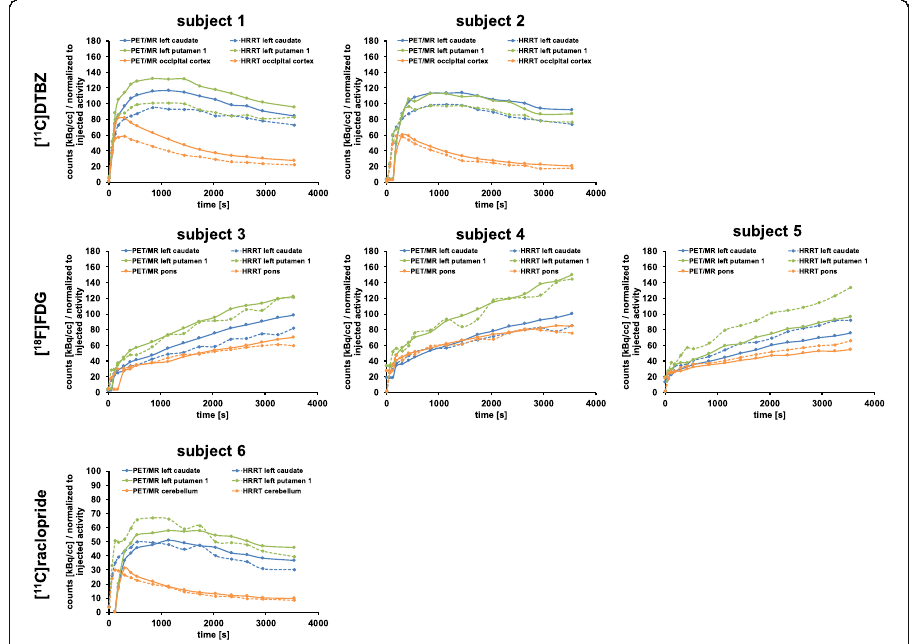
Fig. 7 Regional time activity curves for each subject for two target regions (left caudate and left putamen 1) and the reference region ([ 11 C]DTBZ: occipital cortex, [ 18 F]FDG: pons, [ 11 C]raclopride: cerebellum) for all subjects. Note that the offset in time activity curves between the PET/MR and HRRT is due to different acquisition start triggering mechanisms (HRRT: manual acquisition start; PET/MR: acquisition start based on counts). Solid lines represent the PET/MR data, dotted lines the HRRT